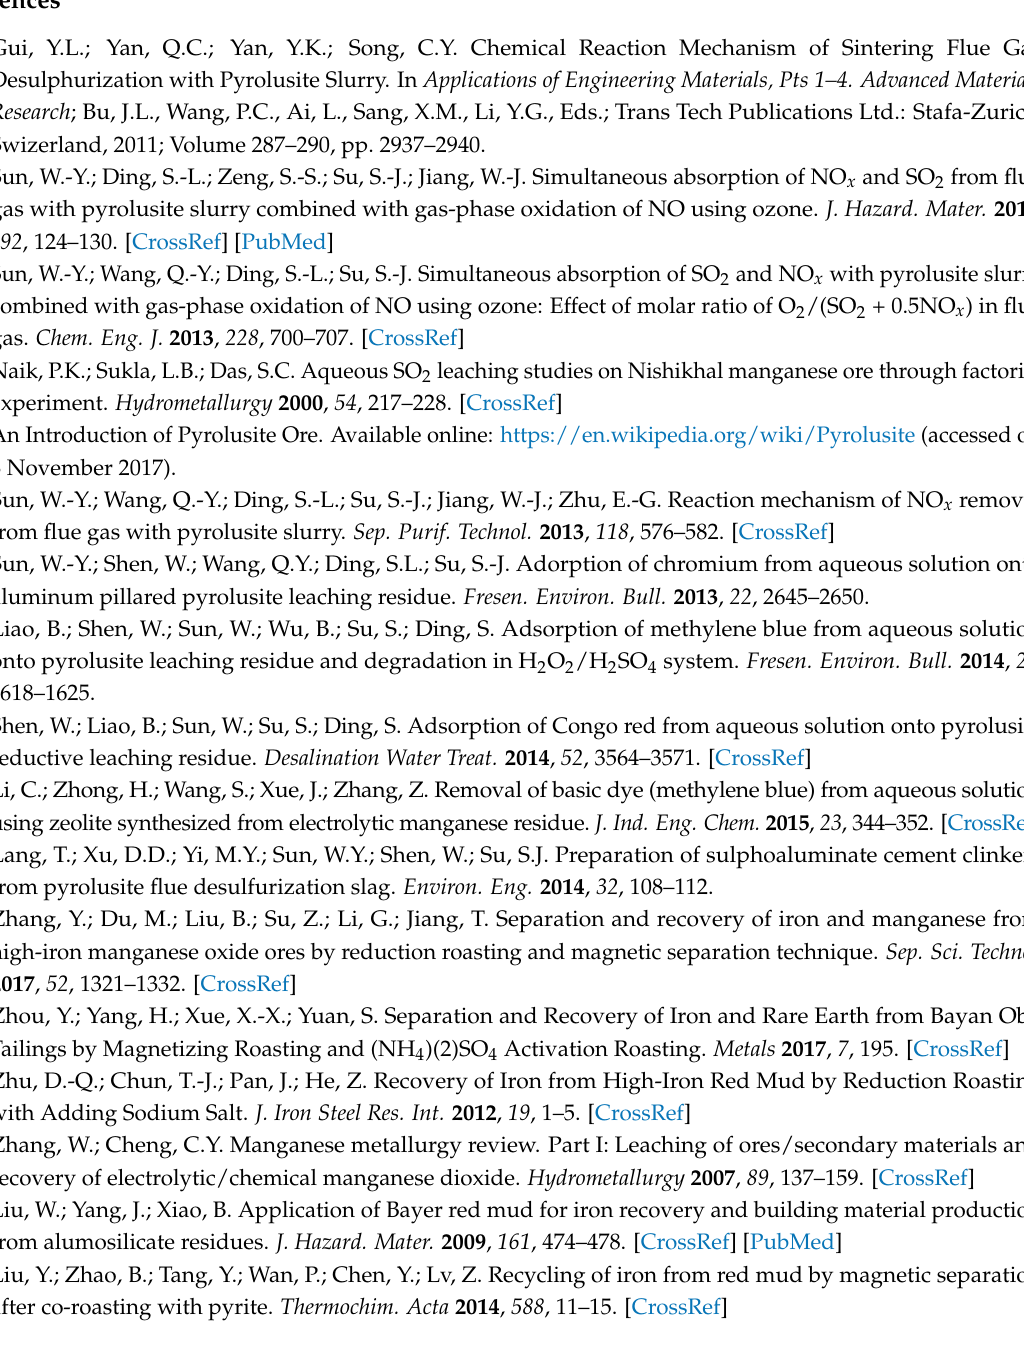
Figure S1: Schematic diagram of the sulfation roasting equipment, Figure S2: The simulation results for iron roasting process, Figure S3: The simulation results for manganese roasting process, Table S1: Iron extraction from ores using ammonium sulphate roasting data reported in